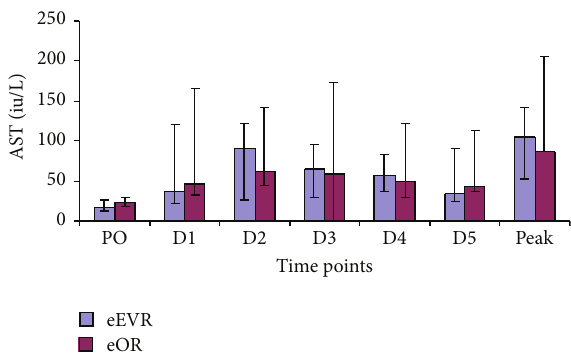
Figure 4: ACR levels in the eEVAR versus eOR groups preopera- tively then, D2, D3, and D5 expressed as median and IQR. 𝑃 = 0.047 for D3 compared to PO in the eOR group (Wilcoxon signed ranks test).